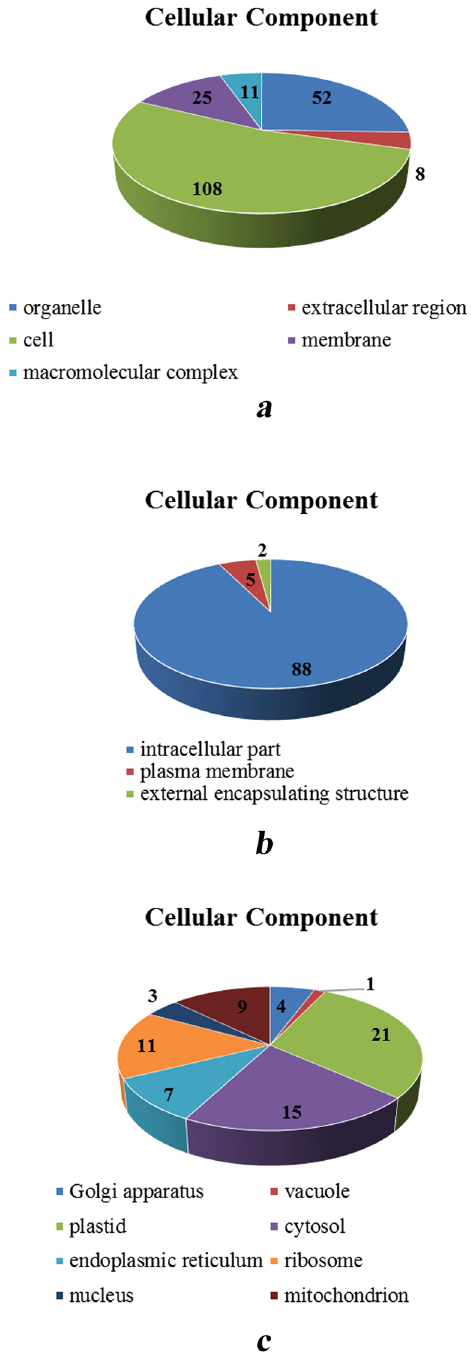
Figure 4. Cellular components are annotated in different GO level. ( a ) GO level 2, ( b ) GO level 5, ( c ) GO level 8. The number represents the number of differentially expressed